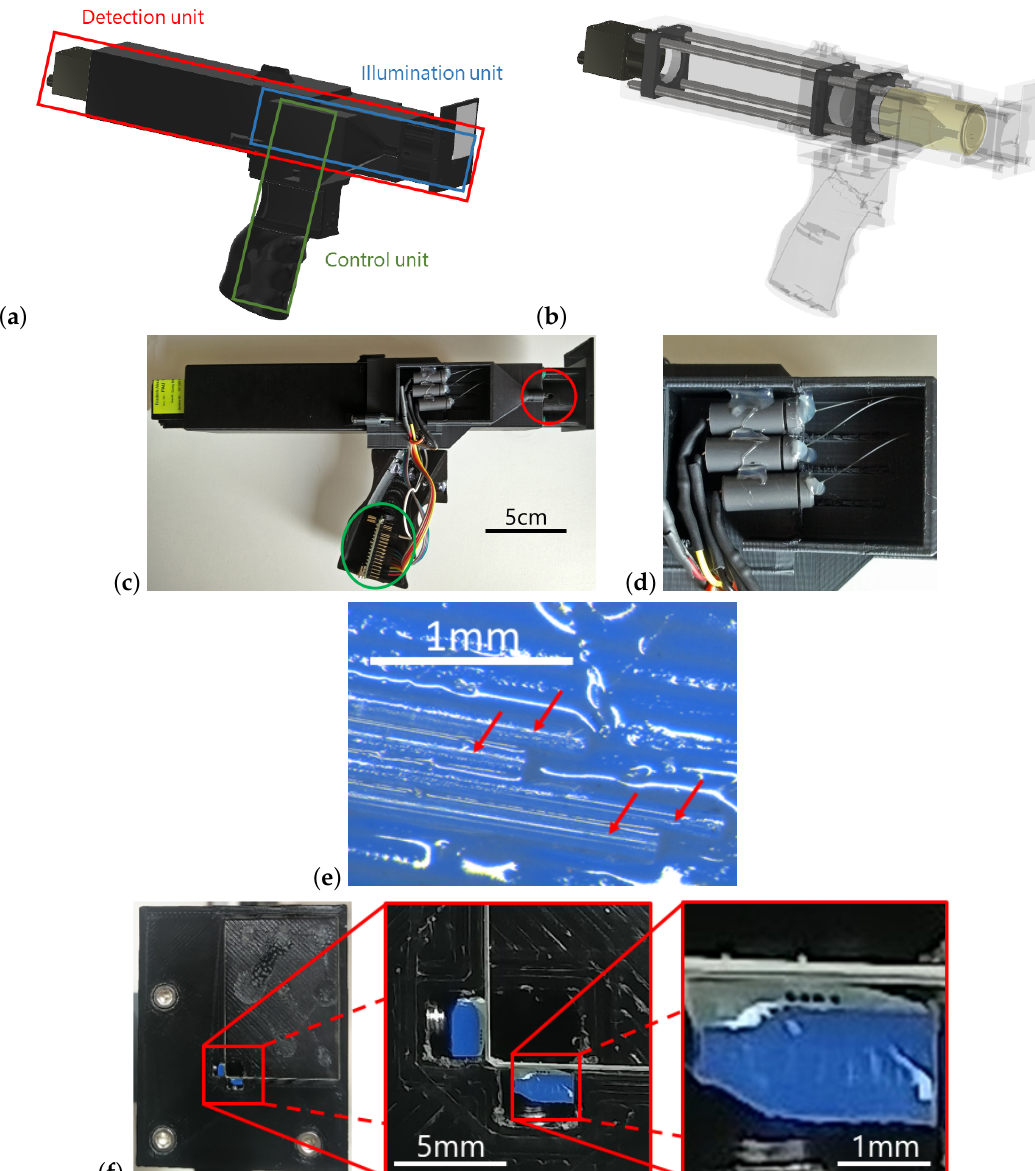
Figure 1. ( a ) CAD illustration of the overall system consisting of an illumination unit and a detection unit and the control of the LEDs via the Arduino Nano. The pistol grip allows for an ergonomic handling of the sensor during measurements. ( b ) By rendering the housing transparent, the optical components of the detection unit become visible. ( c ) Photograph of the side view of the sensor. The cover in the area of the LED light coupling is opened, as is the cover of the Arduino Nano (green circle). The optical fibers are guided into the head of the sensor (red circle). The coupling of the remaining three fibers is located on the opposite side of the sensor. ( d ) Detailed view of the LED light coupling. The housemade sockets can be seen, each of which contains an LED and a ball lens and from which the optical fibers lead out. ( e ) FDM auxiliary construction to hold the distal fiber ends (view parallel to fibres). The fibers are glued into the grooves with two-component epoxy adhesive. The block is then afterward polished from the front as described in the main text. The image shows four optical fibers (marked by red arrows), but only three of them were in use. ( f ) Front of the sensor with the cover glass. The first zoomed-in section of the image displays the aperture through which the detection optics are focused on the sample under investigation, as well as adjacent to that the two illumination fiber blocks. The second zoomed-in section shows the end of a fiber block, the four glued-in and polished fibers are clearly